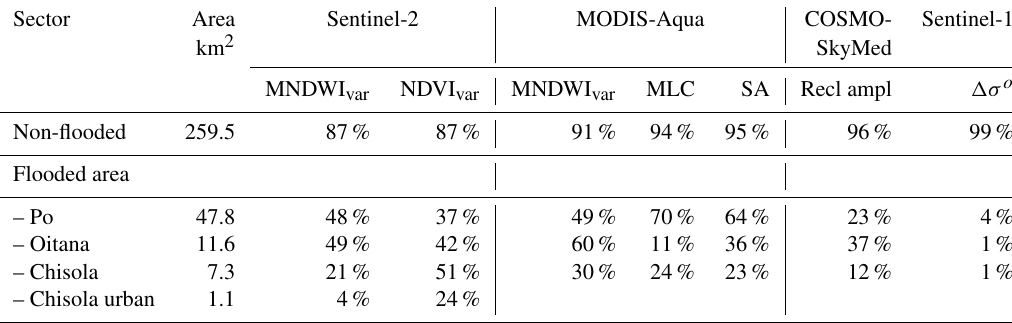
Table 6. Accuracy in automatic flooded and non-flooded area detection. Sector Area Sentinel-2 MODIS-Aqua COSMO- Sentinel-1 km 2 SkyMed MNDWI var NDVI var MNDWI var MLC SA Recl ampl (cid:49)σ o Non-flooded 259.5 87% 87% 91% 94% 95% 96% 99% Flooded area 47.8 48% 37% 49% 11.6 49% 42% 37% 1% 7.3 21% 51%